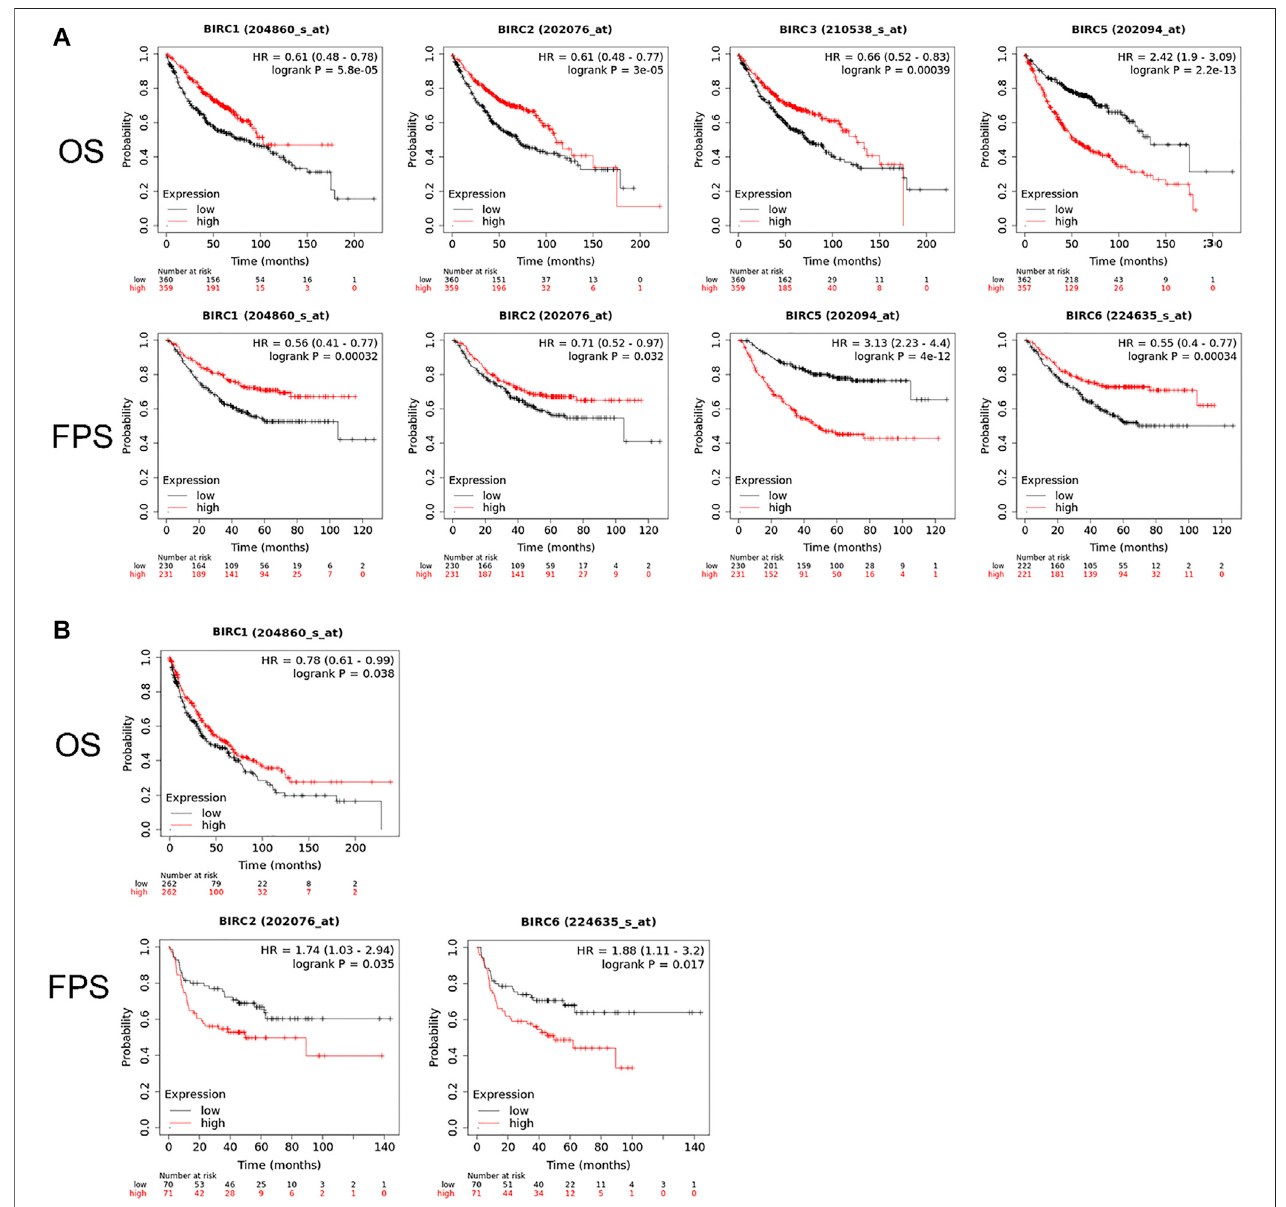
FIGURE 3 | Prognostic value of IAP mRNA expression in patients with NSCLC. (A) IAPs signi fi cantly associated with the prognosis of LUAD patients. (B) IAPs signi fi cantly associated with the prognosis of LUSC patients. NSCLC, non – small cell lung cancer; LUAD, lung adenocarcinoma; LUSC, lung squamous cell carcinoma; OS, overall survival; PFS, progression-free